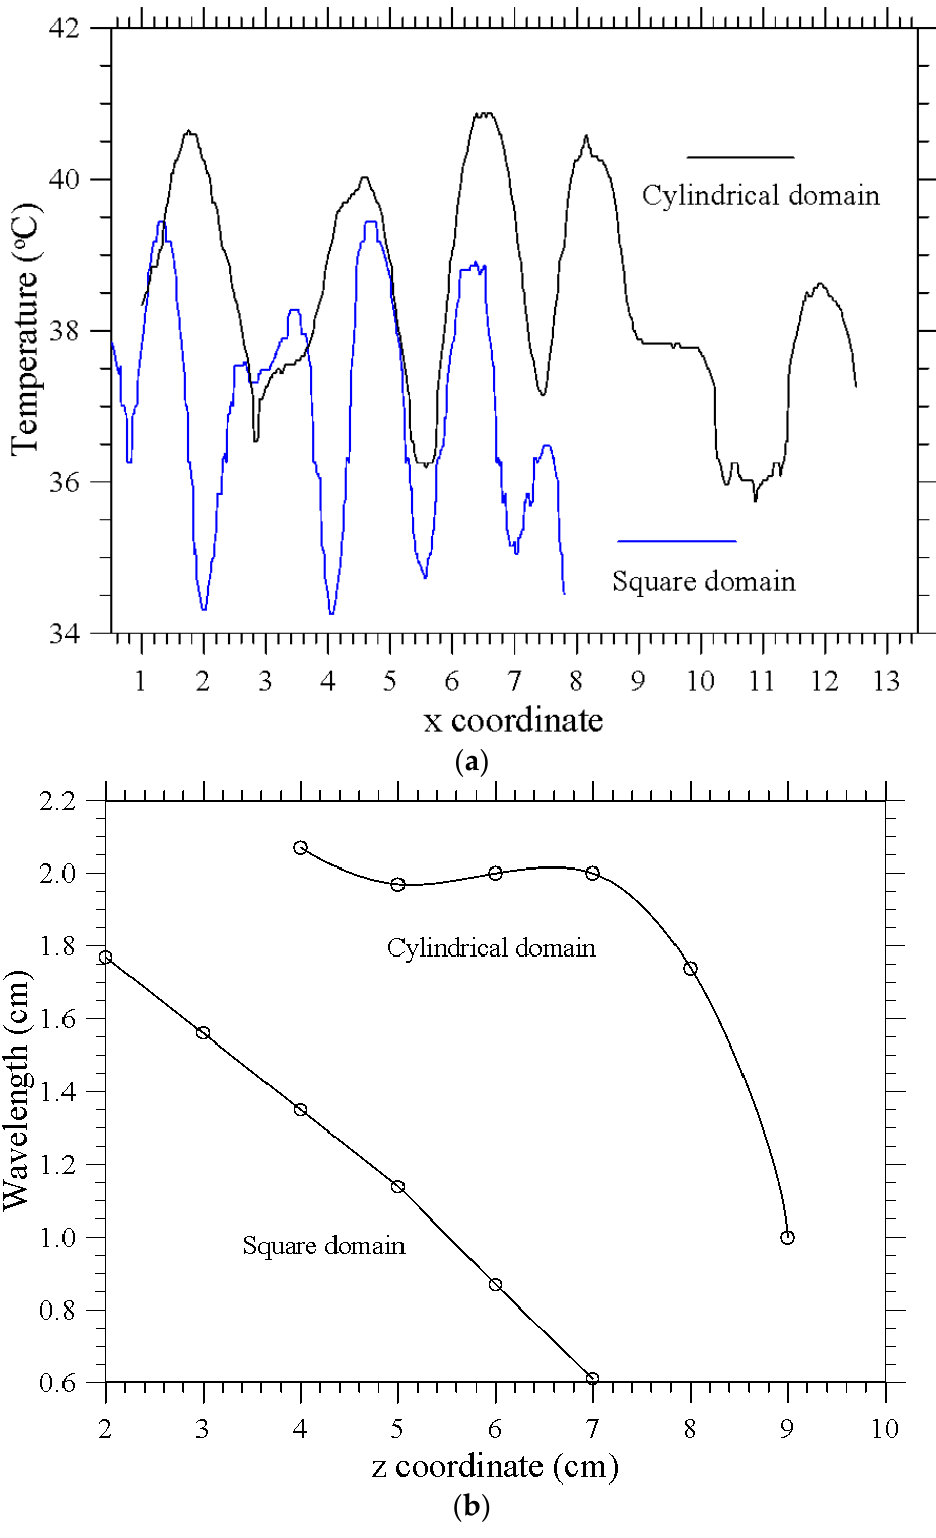
Figure 15. Transverse roll extension analysis ( d = 0.50 cm, Bo dyn ≅ 0.86, ∆ T = 27 °C, ϑ ≅ 3.5°): ( a ) Temperature as a function of the transverse coordinate x at z= 4 cm, ( b ) Roll extension along x as a function of the longitudinal direction z.